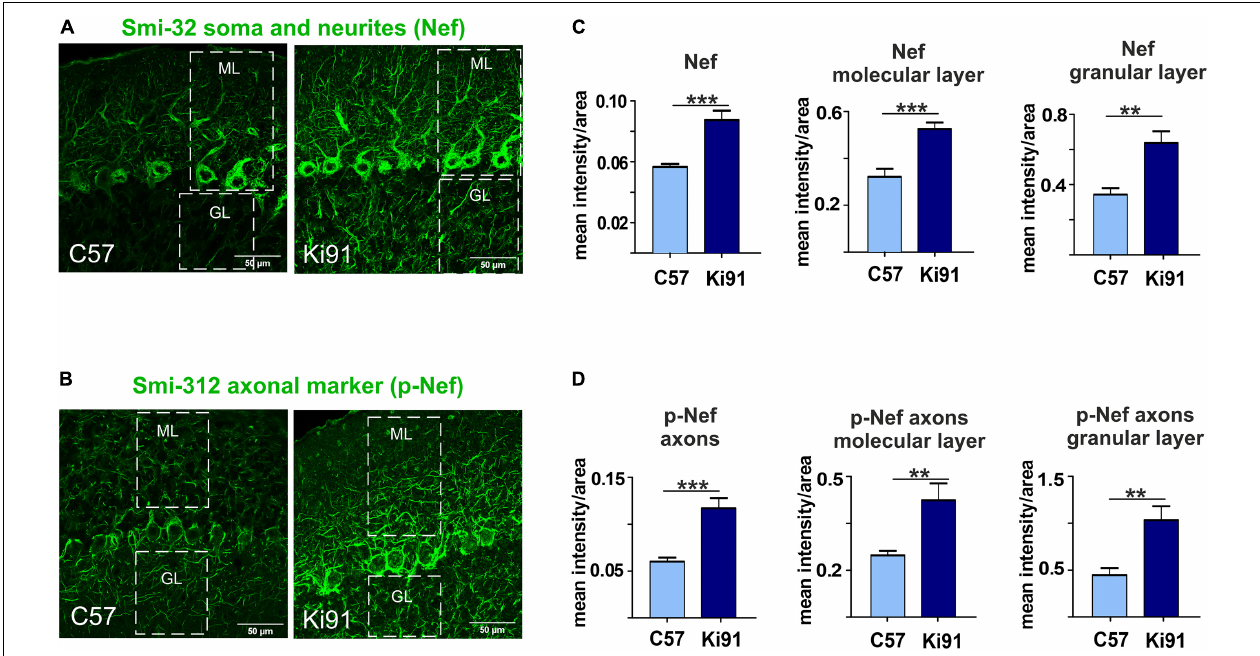
FIGURE 9 | Accumulation of neurofilaments in the cerebellar neurons of Ki91 SCA3/MJD brain. Immunofluorescent staining of the cerebellar sections from 12-month-old mice evaluates the condition of neuronal cytoskeleton and phosphorylation state of neurofilaments in axons. The staining shows the accumulation of phosphorylated neurofilaments in SCA3 cerebellar axons, which is often a sign of axonal stress. Also, the non-phosphorylated pan-neuronal neurofilaments also show increased staining intensity indicating altered cytoskeleton in SCA3 neurons. Scale bars: 50 µ m (A,B) . Non-phosphorylated heavy neurofilaments (Nef) detected with SMI-32 antibody (pan-neuronal) are presented in panel (A) . Phosphorylated neurofilaments H and M detected with SMI-312 (p-Nef; axon-specific) are shown in (B) . White boxes inside pictures (A,B) mark the area, which was used for measuring the mean intensity of the fluorescence comprising the molecular and granular layer of the cerebellum. Measurement of mean intensity of fluorescence using ImageJ and statistics ( p < 0.05; two-sample t -test) performed for sections as a whole and for both layers separately is presented on the graphs (C,D) . Axon-specific SMI-312-positive neurofilaments were highly phosphorylated in both layers in the cerebellum of the Ki91 animals (molecular layer, p < 0.001; granular layer, p < 0.01; two-sample t -test) (B,D) . Moreover, the level of dephosphorylated neurofilaments was also elevated in both cerebellar layers of the Ki91 ( p < 0.01; two-sample t -test) (A,C) . N = 3 biological replicates and 10 confocal images per genotype were collected. Two-sample t-test (* p < 0 . 05, ** p < 0 . 01, *** p < 0 . 001), error bars: SEM.